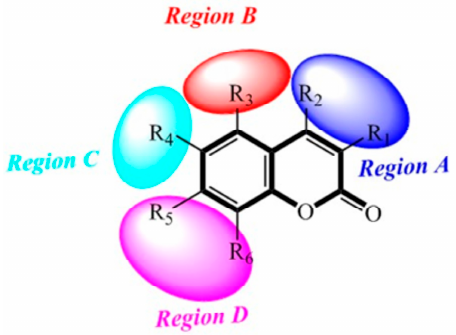
Figure 12. Steric ( A ), electrostatic ( B ), hydrophobic ( C ), and H-bond ( D ) contour maps obtained using CoMSIA-derived models based on molecule 2. Green ( A ) indicates regions where the introduction of a bulky group would increase activity. Yellow ( A ) indicates regions where the introduction of a bulky group would decrease activity. Blue ( B ) indicates regions where the introduction of electropositive groups is favored. Cyan ( C ) indicates regions where the introduction of hydrophobic is favored. Purple ( D ) indicates regions where the introduction of H-bond acceptors is favored. Red ( D ) indicates regions where the introduction of H-bond acceptors is disfavored. The others in Figure A – D represent the compound 2 (Red, oxygen atoms; yellow and blue, nitrogen atom; cyan, hydrogen atom; gray, carbon atoms). Int. J. Mol. Sci. 2017 , 18 , 1380